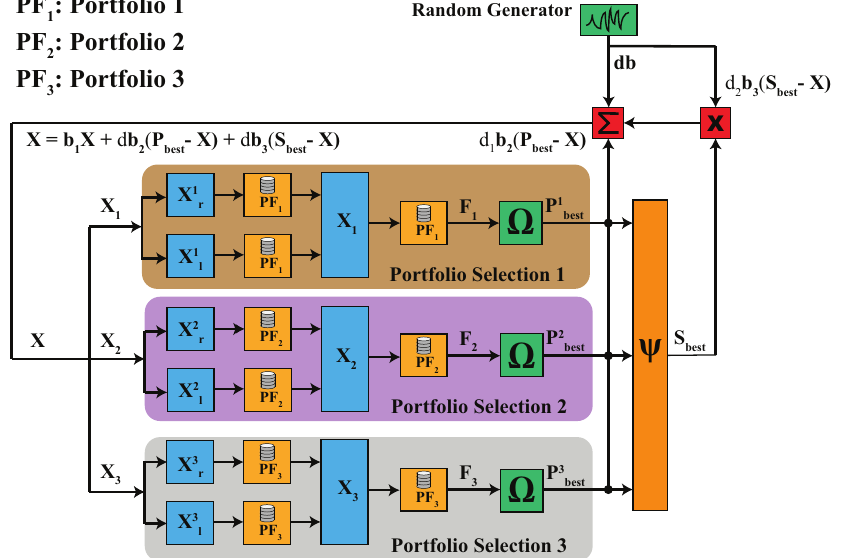
Figure 2. The schematic of the DBAS algorithm for the multi-portfolio selection problem. It consists of 3 portfolios and clearly shows that each particle [ X 1 , X 2 , X 3 ] optimizes portfolio PF 1 , PF 2 , and PF 3 , respectively. It can be seen that particles do not share any portfolio database or stock information among the swarm, which ensures